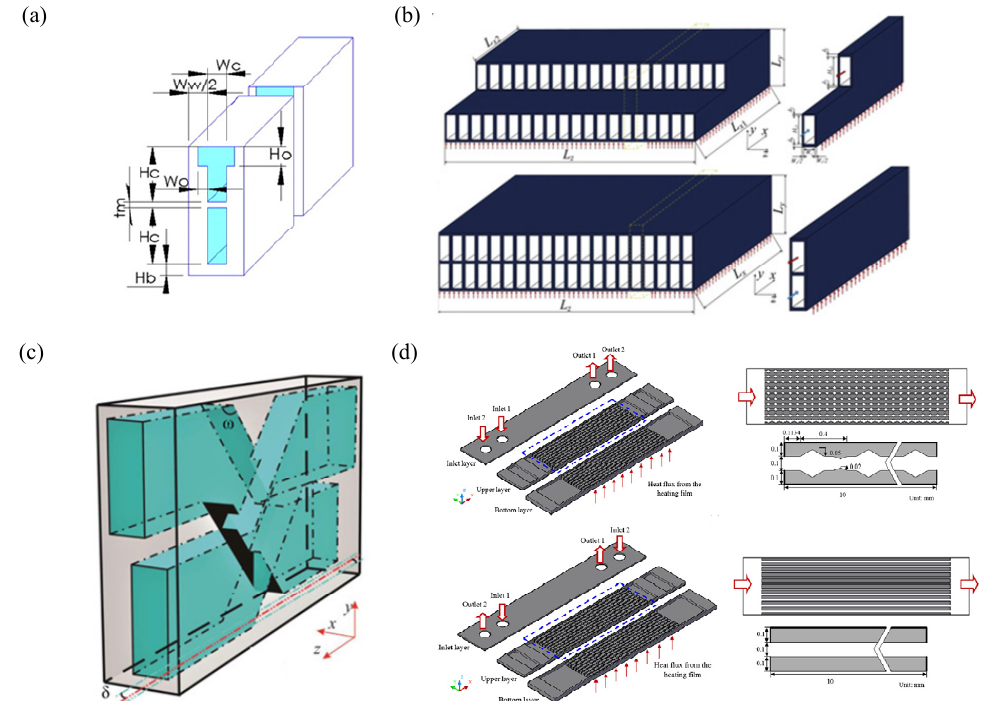
Figure 19. Geometry optimization of fractal microchannel: ( a ) Debbarma et al. (adapted from Ref. [124]), ( b ) Leng et al. (adapted from Ref. [126]), ( c ) Shen et al. (adapted from Ref. [127]), ( d ) Zhai et al. (adapted from Ref. [129]).